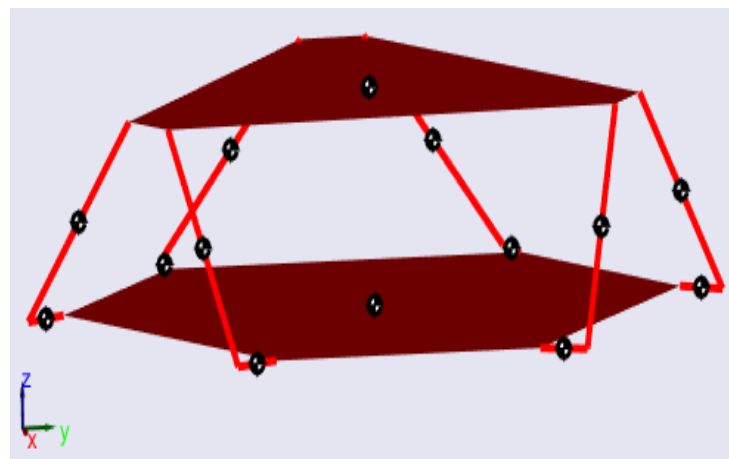
Figure 6. 3D animation of 6-RSS parallel robot.